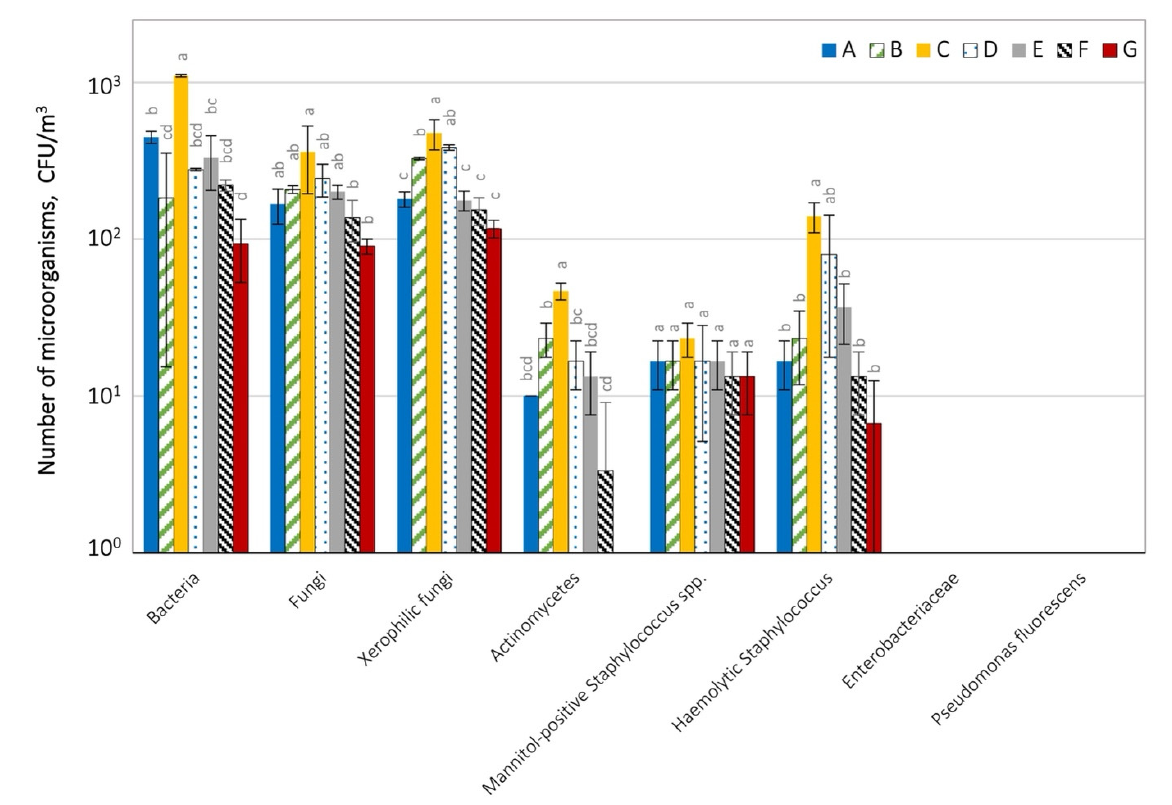
Figure 4. Microbiological air contamination at the tested landfill; A–G air sampling sites; statistically different samples within the same microorganism group were marked with different letters (Tukey’s test at p = 0.05).